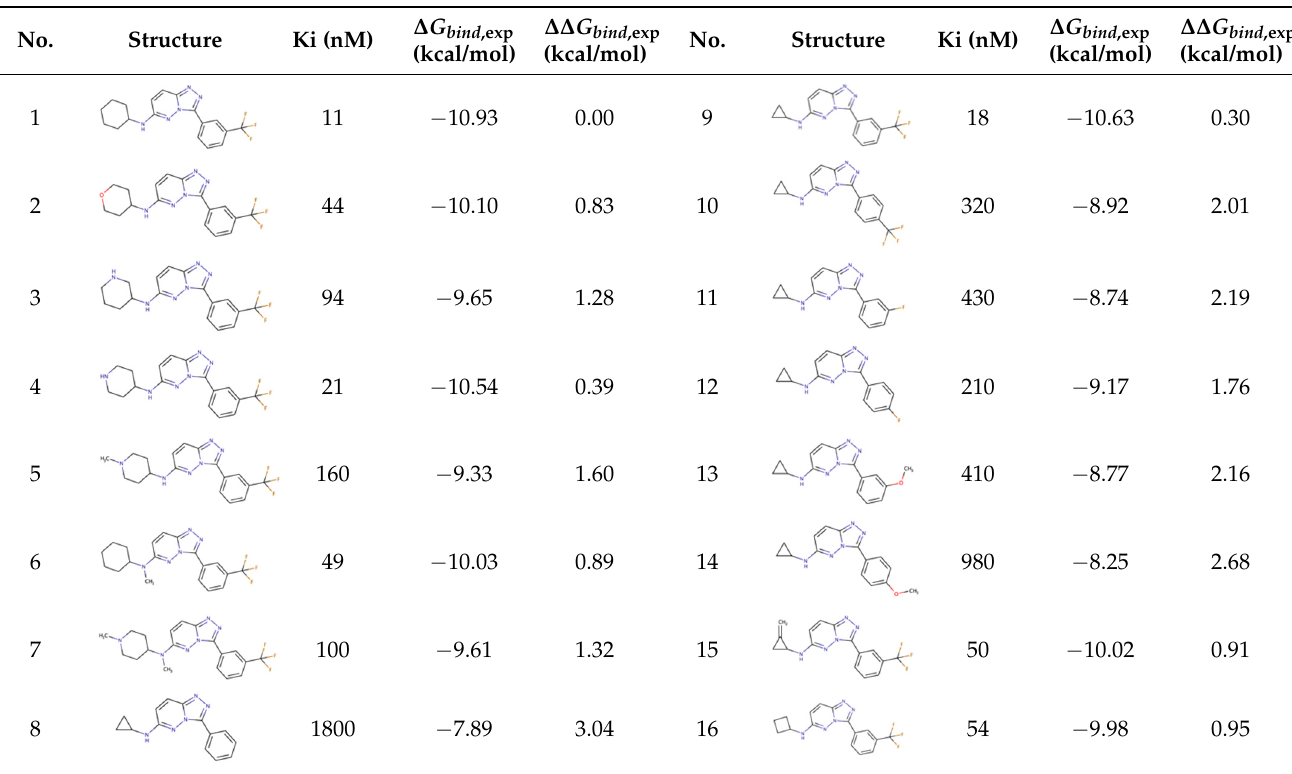
bind ,exp is the experimental value of the binding free energy